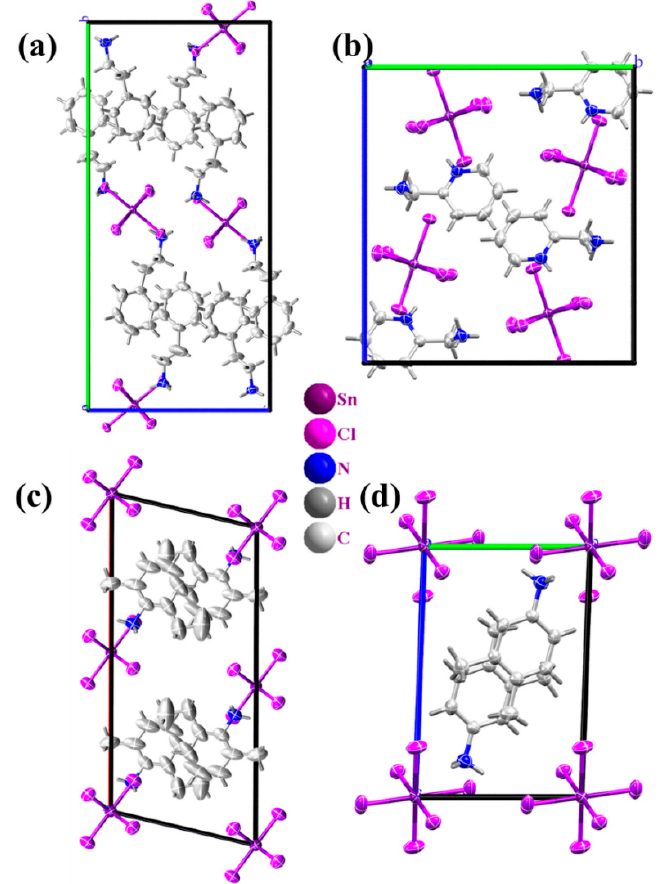
Figure 1. Projection of crystal structure of the four perovskites ( a ) (NH 3 (CH 2 ) 2 C 6 H 5 ) 2 [SnCl 6 ], ( b ) (C 6 H 10 N 2 )[SnCl 6 ], ( c ) (C 9 H 14 N) 2 [SnCl 6 ], and ( d ) (C 8 H 12 N) 2 [SnCl 6 ], which were employed to model the perovskites in this work using substitution of organic cations. Table 1. Summary of the Van der Waals interactions in the different structures.